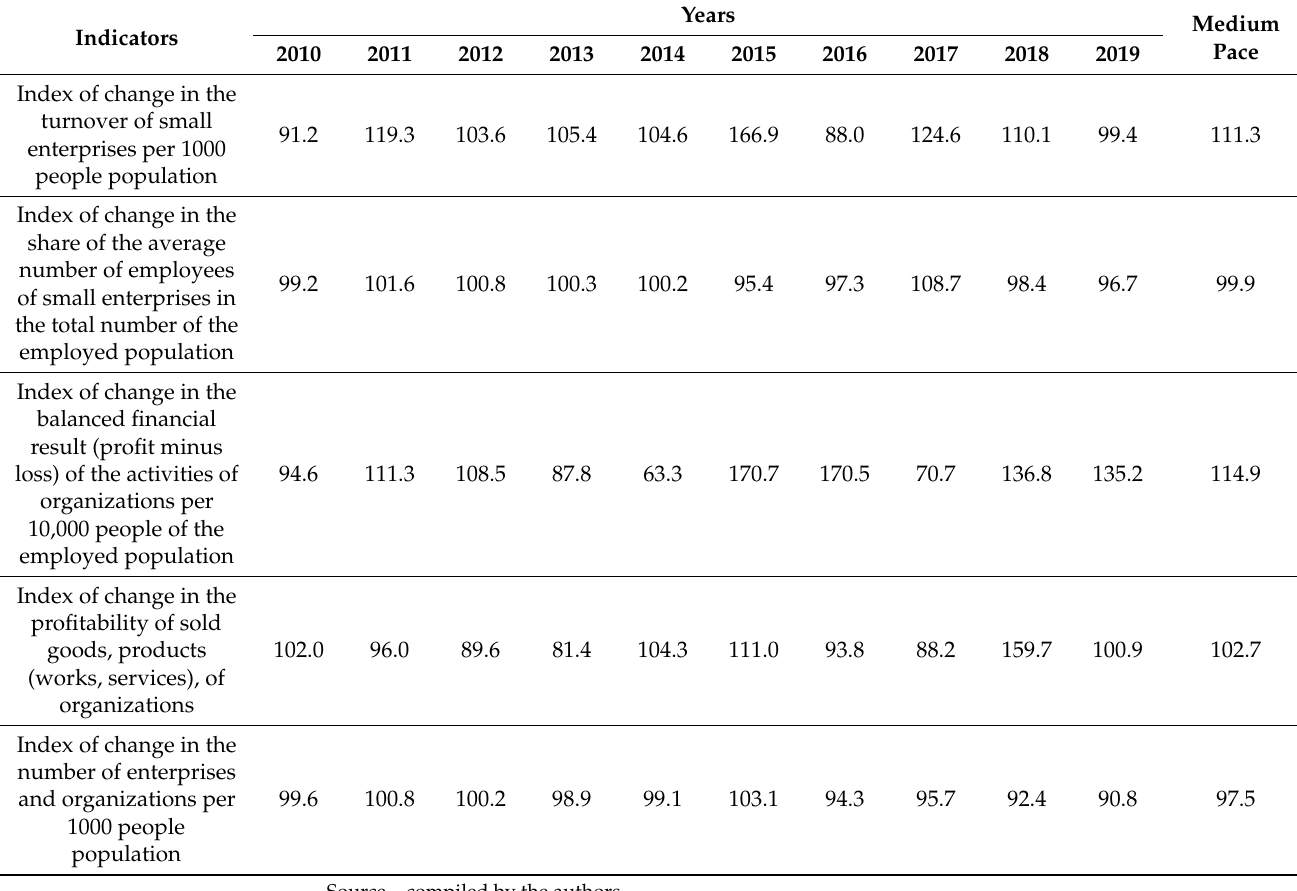
Table 6. Dynamics of changes in indicators characterizing the macro-regional block “Business” in the Russian Federation in 2010–2019, in % of the previous